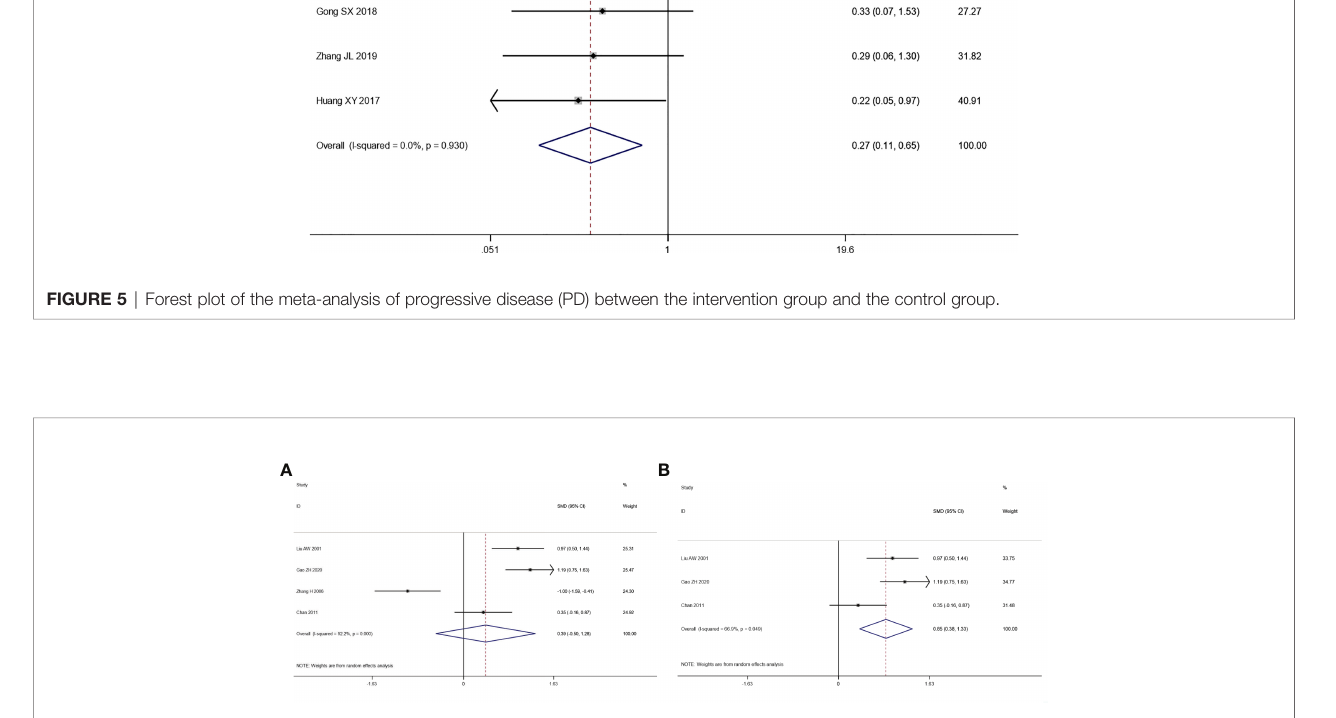
FIGURE 6 | Forest plot of the meta-analysis of quality of life (QOL) before sensitivity analysis (A) and after sensitivity analysis (B) between the intervention group and the control group.